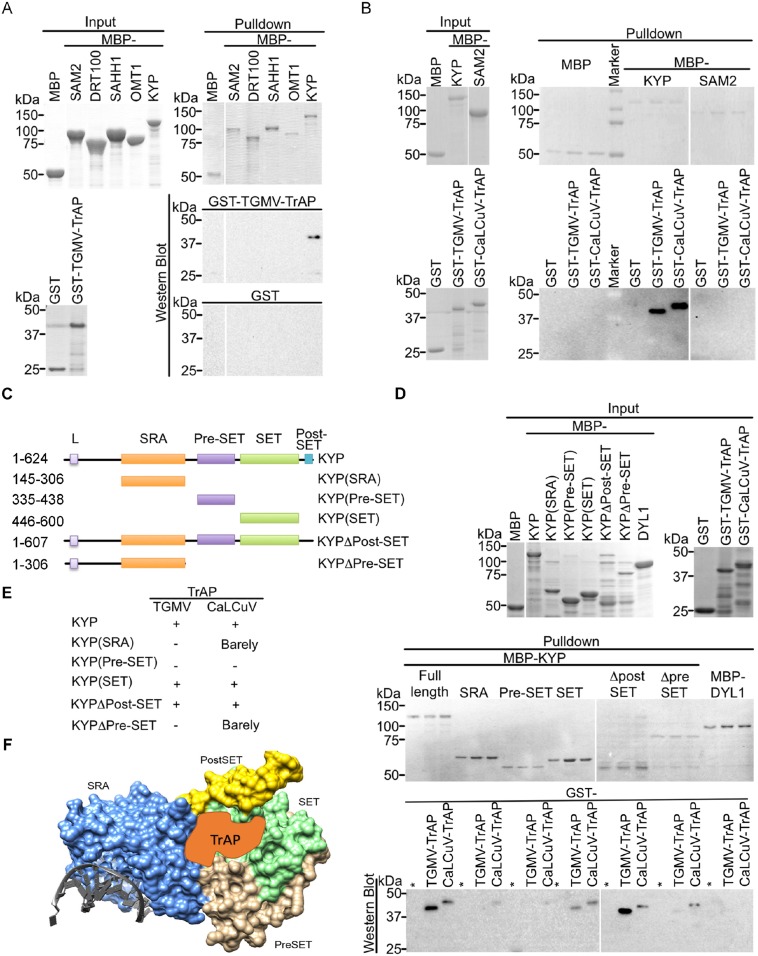
TrAP interacts directly with KYP through the SET domain.(A, B) In vitro pull-down assays showed that KYP specifically interacted with TGMV TrAP (A) and CaLCuV TrAP (B). Left panel, Coomassie brilliant blue R250 staining of the proteins shows their mobility. Right panel, output of in vitro pull-down assays. All His-MBP-tagged bait proteins and His-GST-tagged prey proteins were purified from Escherichia coli using Ni-NTA columns. In all assays, 2.5 μg of prey proteins were pulled down with the indicated bait proteins (2.5 μg each) using amylose resin. The recovered MBP-tagged bait proteins were monitored by Coomassie brilliant blue R250 staining. All the experiments were done at the same time, and the samples were run in the same gels. The spacers in the images indicate digital rearrangements of the pictures. The output of the GST-tagged prey proteins was analyzed by western blot using a monoclonal anti-GST antibody. (C) Schematic diagram of full-length and truncated forms of KYP. The numbers on the left refer to the amino acid residues in KYP protein. Locations of SRA, pre-SET, SET, and post-SET domains are shown. (D) In vitro pull-down assays of truncated KYP proteins and TrAPs. The experiments were done as in (A, B). The GST negative control was loaded in the lanes marked with (*). (E) Summary of interaction between the truncated KYP proteins and TrAP encoded by TGMV and CaLCuV. (F) Model of possible KYP-TrAP interaction based on the experimental results from panels D and E. KYP structure was generated in Chimera from PDB: 4QEN data set (Du et al., 2014b), domains are color coded and indicated.